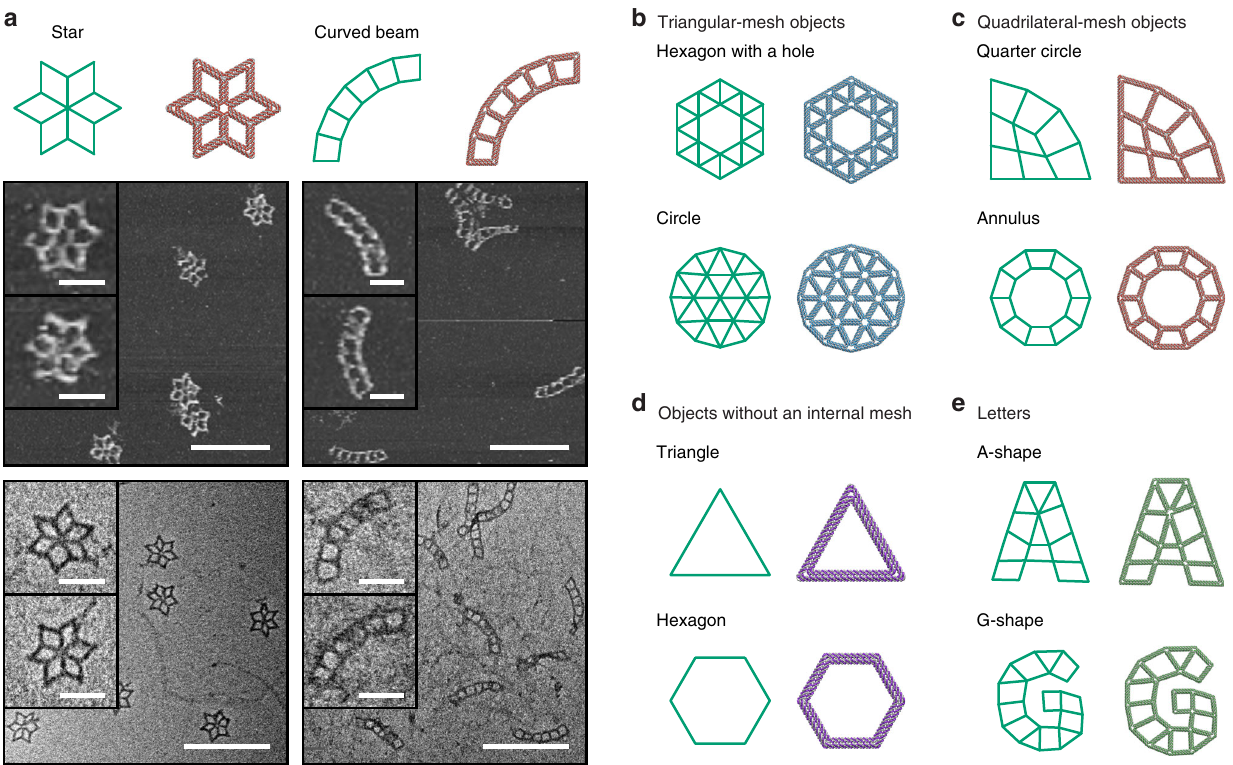
Fig. 5 Fully automatic sequence design of ten diverse scaffolded DNA origami objects with 6HB edges. a Representative (middle) AFM and (bottom) TEM images for a star lattice and curved beam lattice are shown. Target 2D wireframe objects (with green lines) and DNA-based atomic models with b triangular and c quadrilateral meshes, d without internal mesh, and e with irregular meshes. The top zoomed-in image on each panel is the representative object that is the most deformed and the image below represents the object that is the least deformed in shape. Scale bars in zoomed-in and zoomed-out AFM and TEM images are 50 and 200 nm,